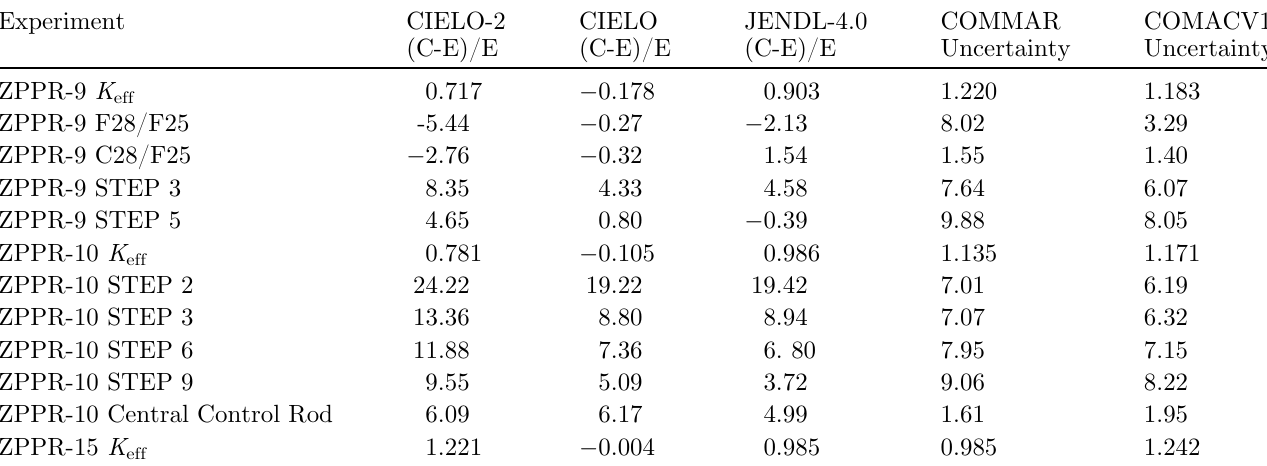
Table 5. (C-E)/E of CIELO and CIELO-2 isotopes and consistency with uncertainty of COMMARA 2.0 and COMACV1: ZPPRs.